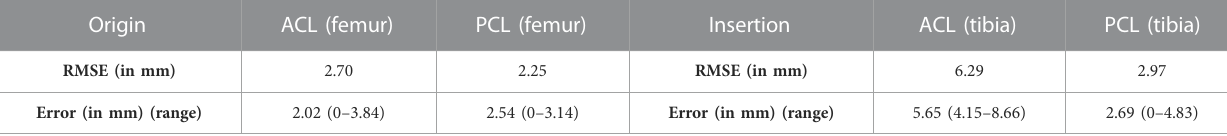
TABLE 5 The RMSE and the median error with range from minimal to maximal error for the ACL and the PCL origin and insertion. Origin